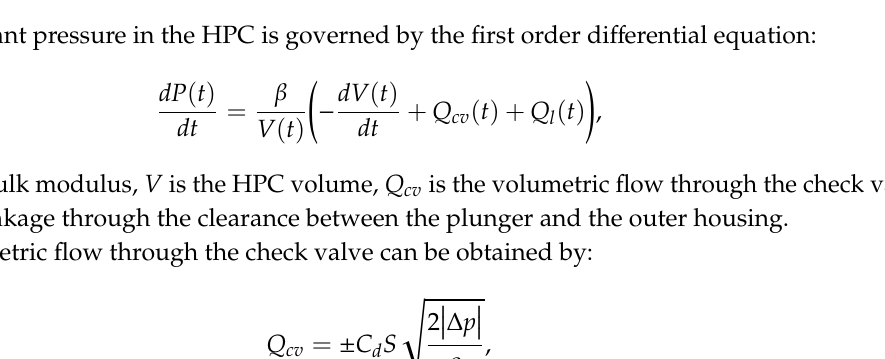
Figure 16. The structure of the hydraulic lash adjuster (HLA).